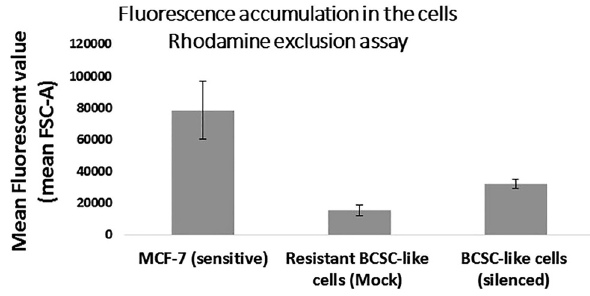
Figure 5: Rhodamine exclusion assay results: Fluorescence accumulation (FL values) in sensitive MCF-7 cells, in drug resistant BCSC-like cells (MOCK) and in silenced BCSC-like cells. As the P-gp activity decreased due to silencing, rhodamine accumulation increased, which meant increased potential for drug